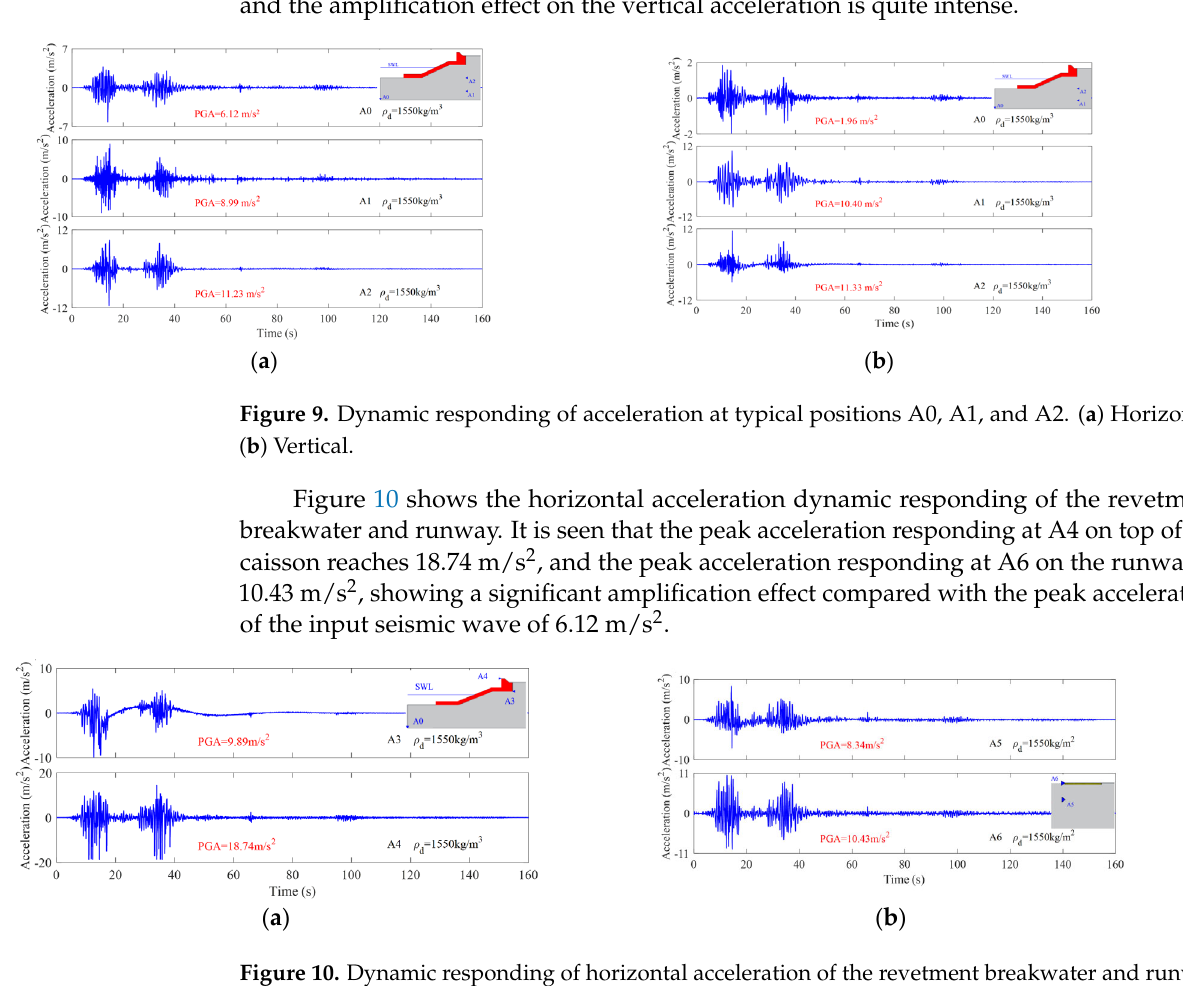
Figure 8. Dynamic responding of displacement of the revetment breakwater and runway. ( a ) Run ‐ way. ( b ) Caisson. ( c ) Revetment.